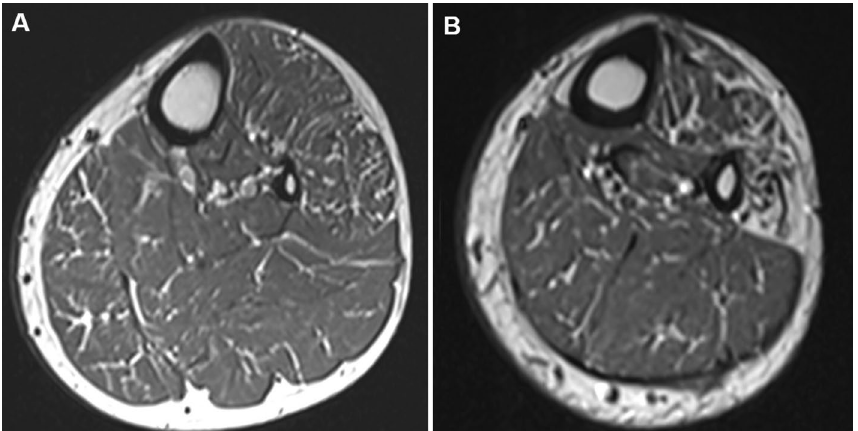
Figure 2. Axial T1-weighted images of the proximal ( A , level 4) and distal ( B , level 5) lower leg in a 30-year-old man with Charcot-Marie-Tooth disease type 1A. Intramuscular fat infiltration was graded using the Mercuri scale at proximal lower leg ( A ) as follows: tibialis anterior, 1; extensor digitorum longus, 1; peroneus longus, 2a; tibialis posterior, 1; soleus, 1; gastrocnemius medialis, 2a; and gastrocnemius lateralis, 1. Fat infiltration proportion (FIP), significant fat infiltration proportion (SigFIP), and severe fat infiltration proportion (SevFIP) were calculated using the following formulas: FIP = number of muscles with stage 1 or higher / number of all evaluated muscles x 100 (%); SigFIP = number of muscles with stage 2a or higher / number of all evaluated muscles x 100 (%); and SevFIP = number of muscles with stage 3 or higher / number of all evaluated muscles x 100 (%). Acquired parameters for this patient were: FIP = 100%, Sig FIP = 28.6%, and SevFIP = 0% at level 4. MRI obtained at the distal lower leg ( B ) shows preferential fat infiltration in the anterior and lateral compartment